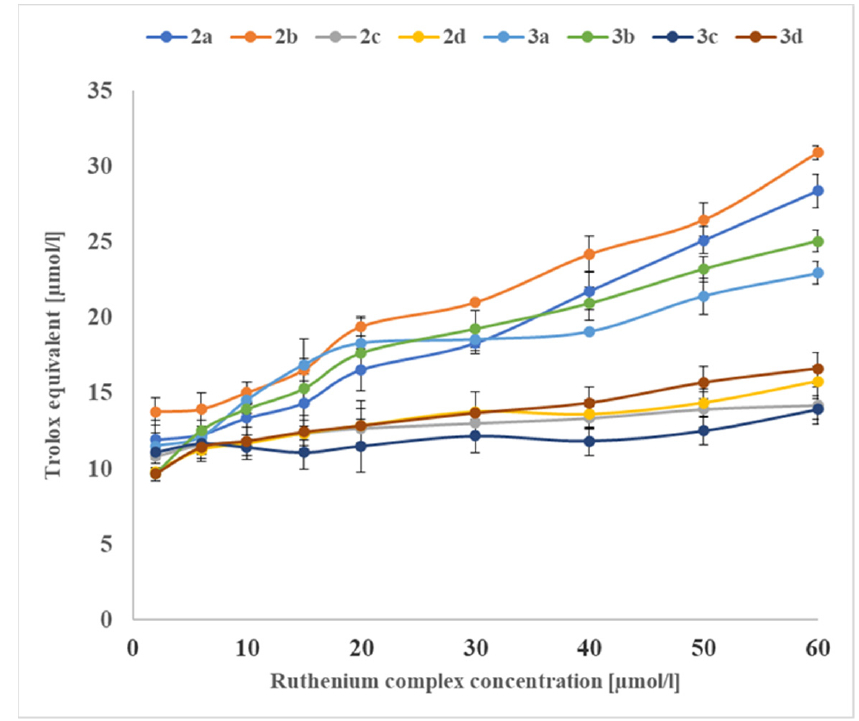
Figure 6. Total antioxidant potential of the analyzed ruthenium complex compounds (µmol/L) was determined using FRAP assay - ferric iron (Fe 3+ ) reduction to ferrous iron (Fe 2+ ). The antioxidant activity of the complexes was expressed as Trolox equivalents (µmol/L) calculated on the basis of a calibration curve. The results represent mean ± SD of data from three individual experiments, repeated at least four times.